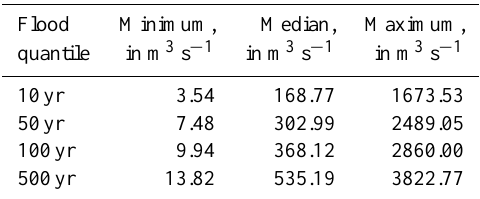
Table 2. Range of empirical flood quantiles across the 61 study streamgauges (Gotvald et al.,